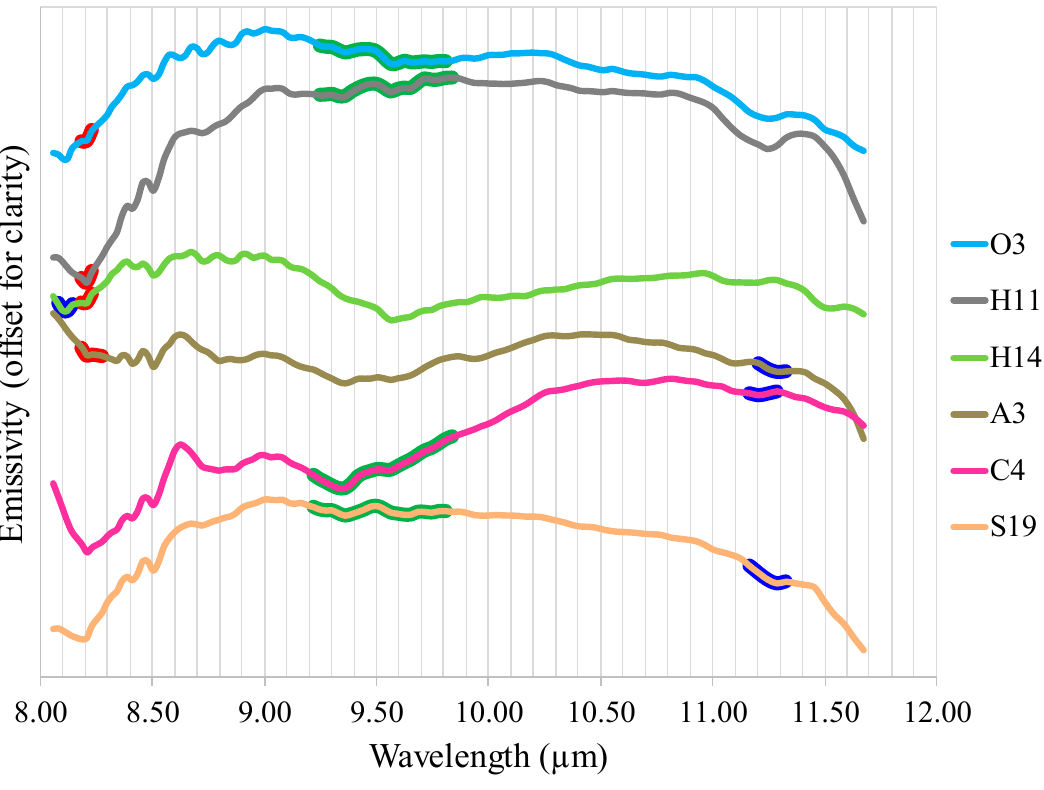
Figure 8. Emissivity spectra of selected C-type (O3, H11), CM-type (H14, A3) and Q-type (C4, S19) soil samples; bold curves represent mineral-related features of the less abundant minerals (blue for carbonates, red for quartz and green for clay minerals) in each sample. Table 4. Spectral indicants and resultant mineralogy of selected soil